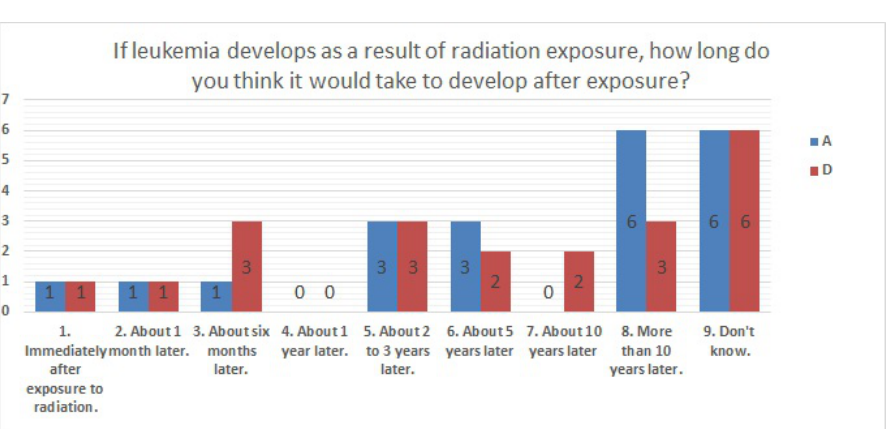
Figure 14. Responses to item No.